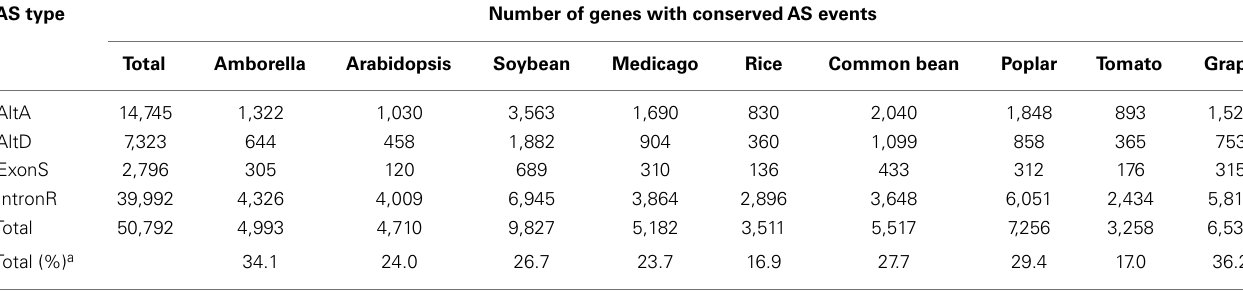
Table 5 | Genes with conservedAS events across at least one other species